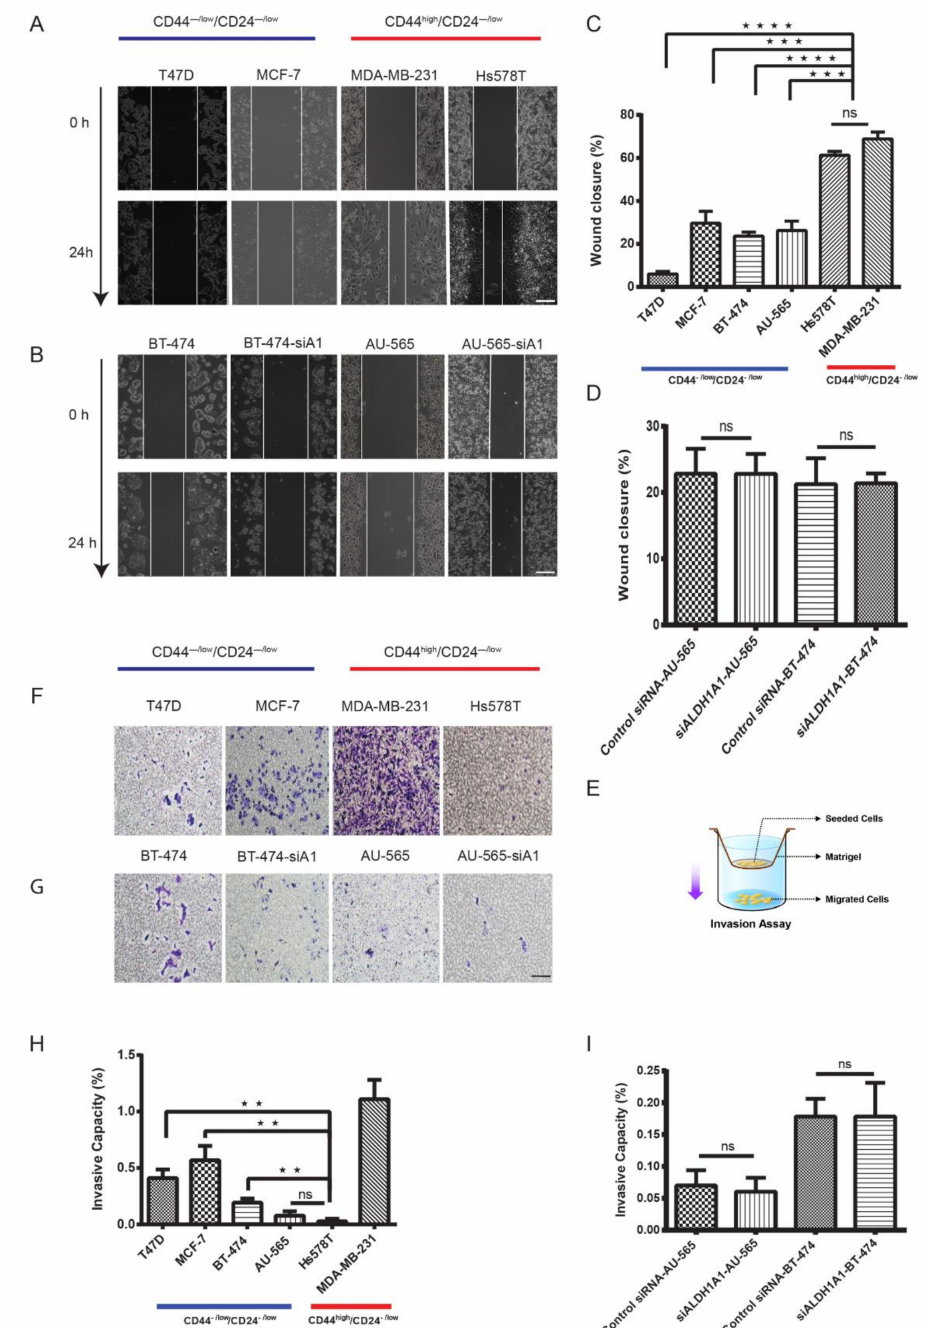
Figure 5. Luminal CD44 − / low / CD24 − / low cells show low migratory but high invasive properties. Representative images and ( A , B ) comparison of the wound closure rate ( C ) of di ff erent populations show that CD44 high / CD24 − / low cells from triple-negative cell lines had a high rate of cell migration. ( E ) Schematicrepresentationofthetranswellinvasionassay. The1 × 10 4 cellsinserum-freemediumwere seeded in matrigel. Cells migrating to lower chambers filled with complete medium were counted after 24 h under a microscope. ( F , G ) Representative images of migrated cells. ( H ) Comparison of invasive capacity showing low invasive properties of CD44 high / CD24 − / low cells and CD44 − / low / CD24 − / low cells from the Hs578T and AU-565 cell lines, respectively. ( D , I ) Comparison of siALDH1A1 with control in HER2-OE cell lines for wound healing and transwell invasion assays. Data represent the mean ± SD (n = 3); ** p < 0.01, *** p < 0.001, and **** p < 0.0001. Scale bar = 200 µ